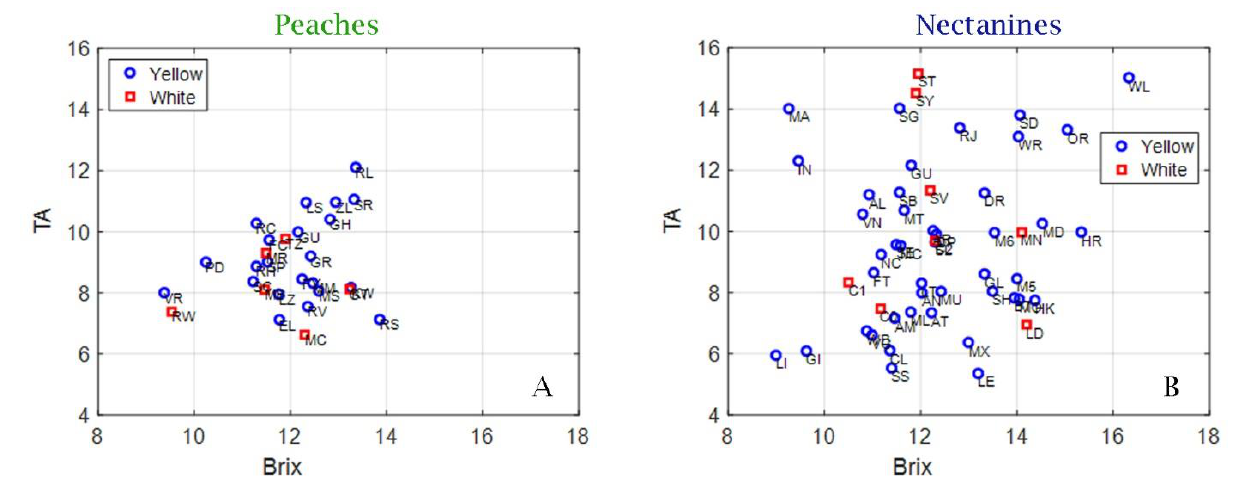
Figure 1. Scatter plots of °Brix and TA for 32 peach cultivars (yellow and white) ( A ) and 52 nectarine cultivars (yellow and white) ( B ).